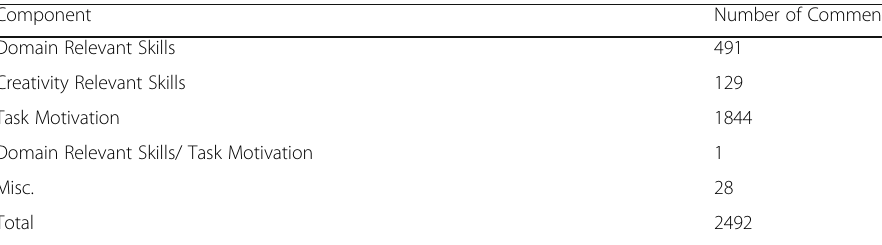
Table 2 Component